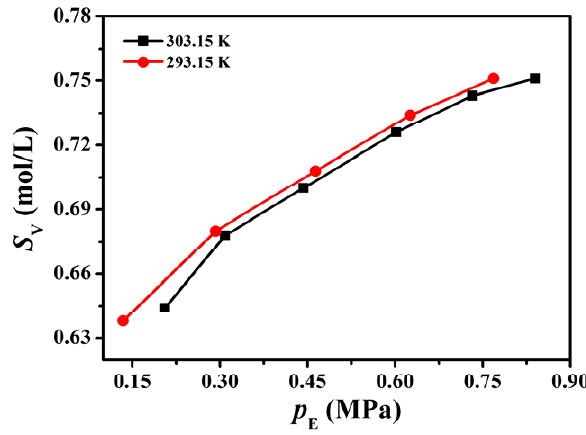
Figure 5. Solubility curve of C 3 H 6 in the ZIF ‐ 8/water ‐ glycol slurry where the mass ratio between water and glycol in the solution was specified to 4:1 with 20 wt % ZIF ‐ 8 at different temperatures.